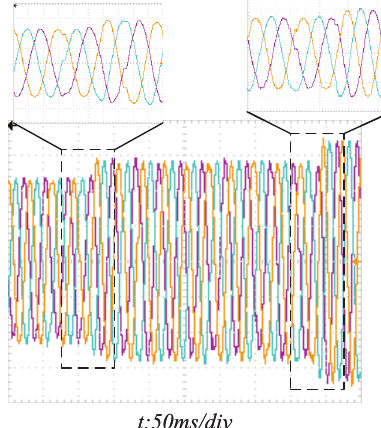
Figure 23. Steady-state current waveform when m = 0.75, D = 0.1.